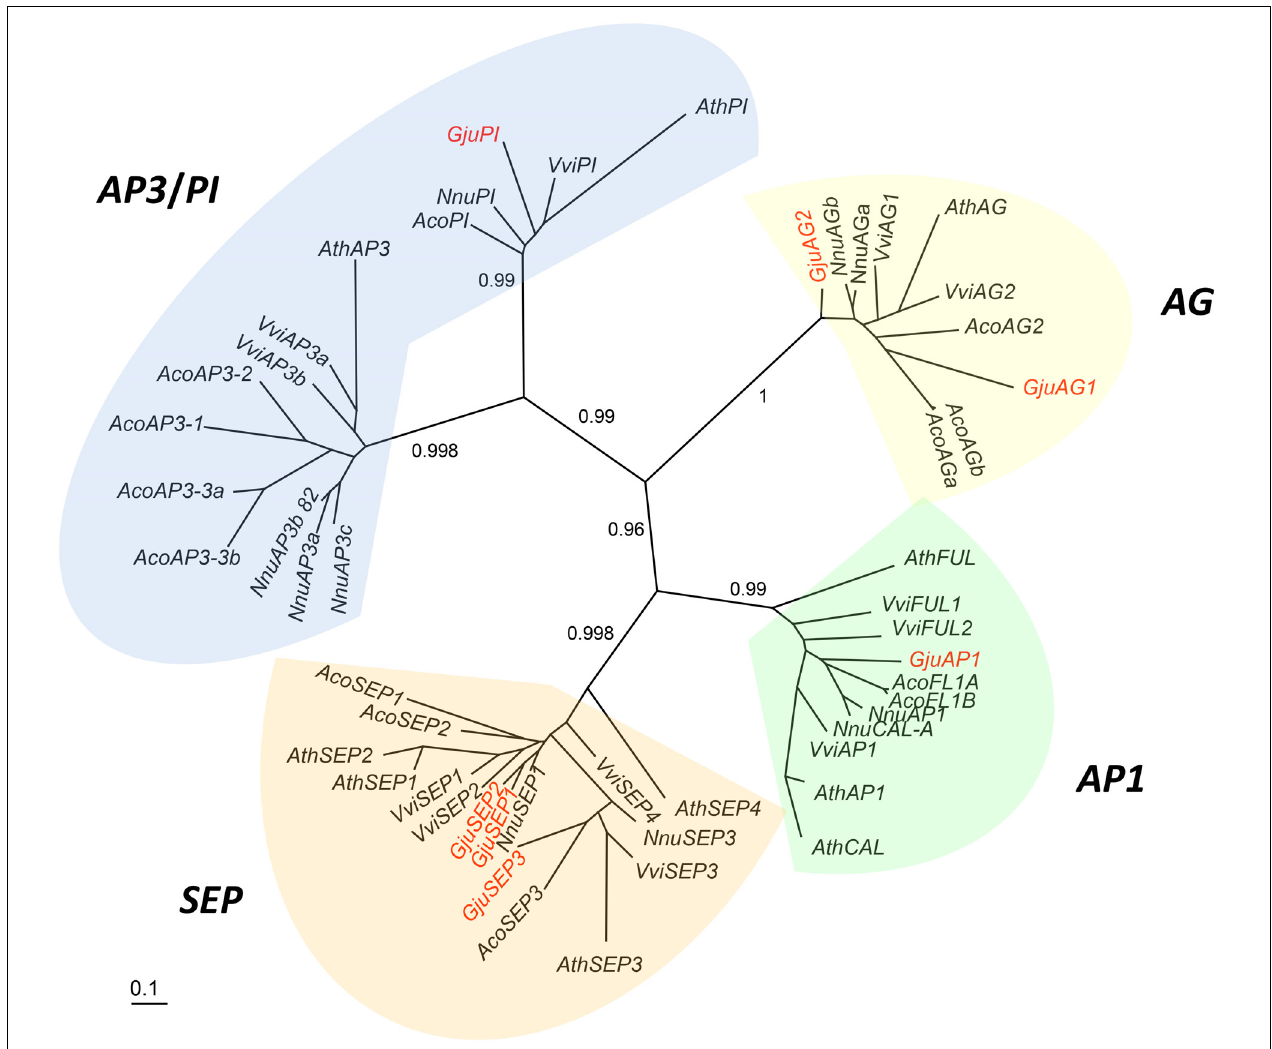
FIGURE 6 | Unrooted phylogram of A-, B-, C-, E-class MADS-box genes. Seven G. juniperina full-length transcripts were included in this analysis. Branches with less than 0.5 aLRT values were collapsed. “Gju” is the abbreviation for Grevillea juniperina, “Vvi” for Vitis vinifera , “Nnu” for Nelumbo nucifera , “Ath” for Arabidopsis thaliana and “Aco” for Aquilegia caerulea genes. Protein IDs are specified in Supplementary Table S2 .